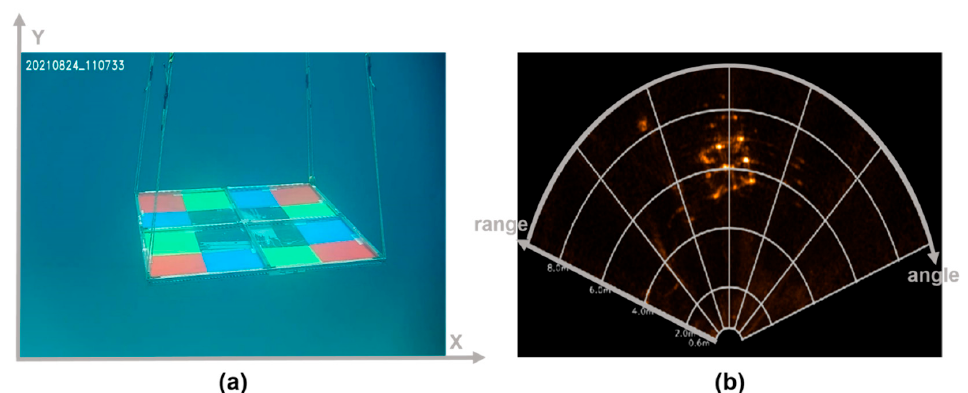
Figure 1. Two image coordinate systems, ( a ) Cartesian and ( b ) fan-shaped image coordinate systems of optical and multi-beam sonar sensors.